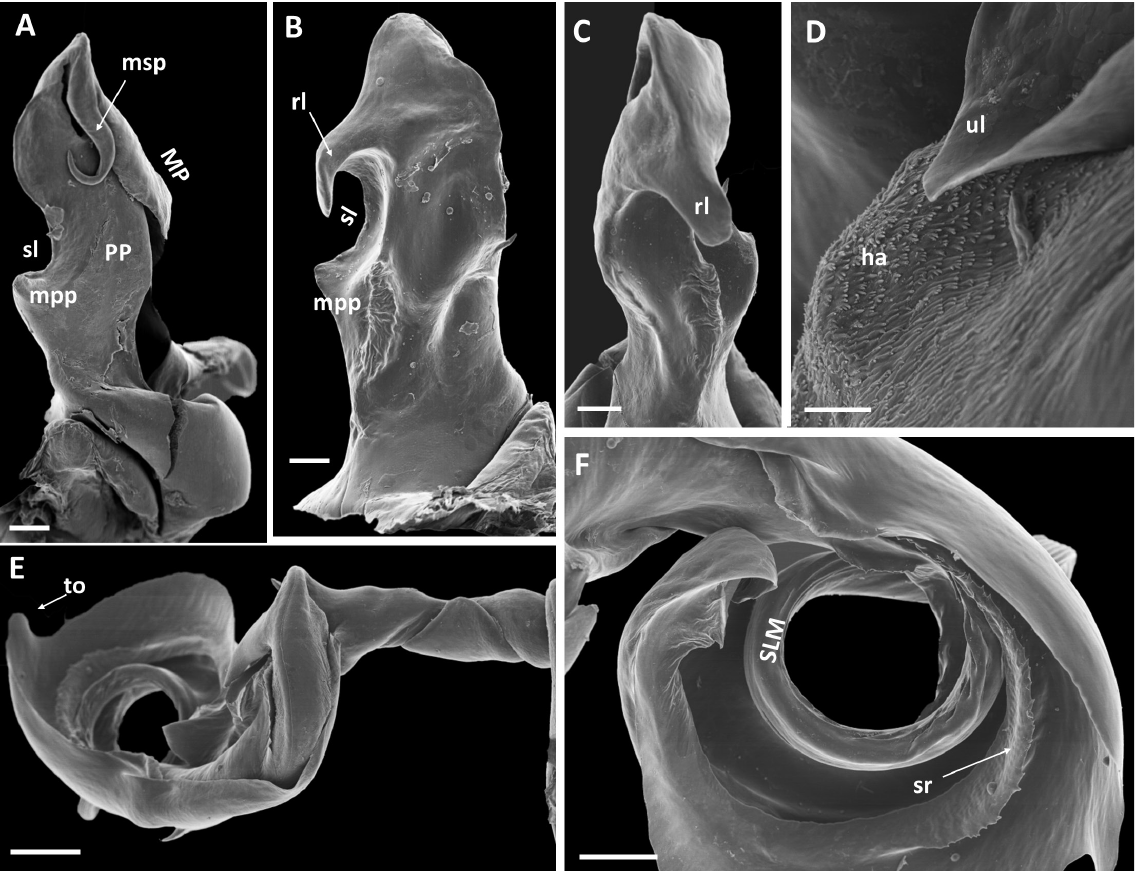
Fig. 23. Calyptomastix zoltani sp. nov., paratype, ♂ from Amani (NHMD 621720). A–C . Left gonopod coxa. A. Lateral view. B. Subposterior view. C. Mesal view. D–F . Left gonopod telopodite. D. Detail from basal outer surface of telomere. E. Posterior view. F. Distal part of telomere, with part of solenomere, posterior-apical view. Abbreviations: ha = ‘hairy’ area; MP = metaplica; mpp = mesal proplical process; msp = metaplical spinelike process; PP = proplica; si = mesal sinus; SLM = solenomere; sr = serrated ridge; to = tongue-like lobe; ul = slightly undulate lamella. Scale bars: A–B, D–E = 0.05 mm; C = 0.1